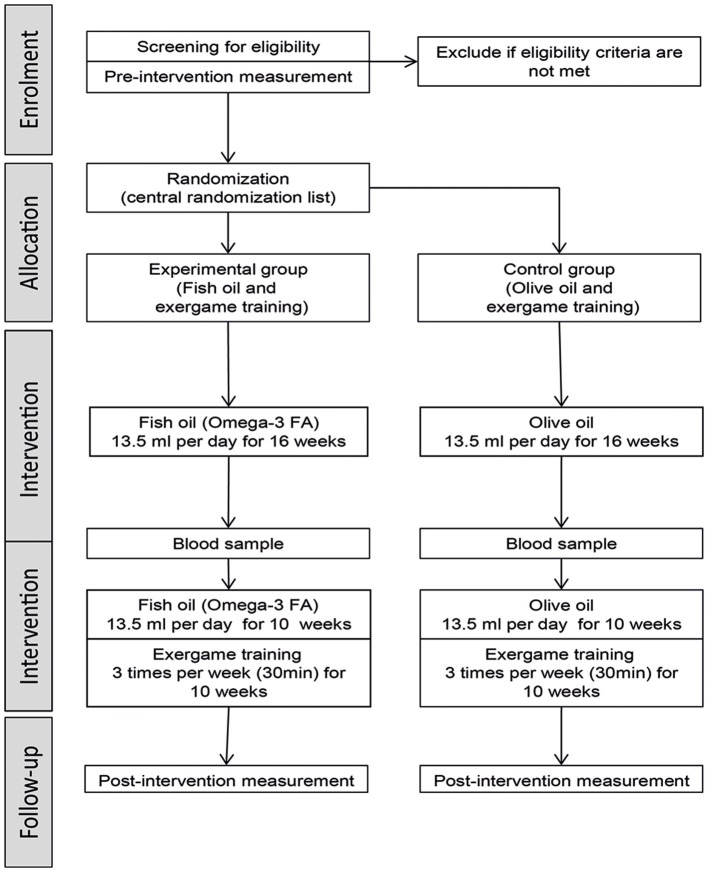
Flow chart of study procedure. FA: fatty acid.